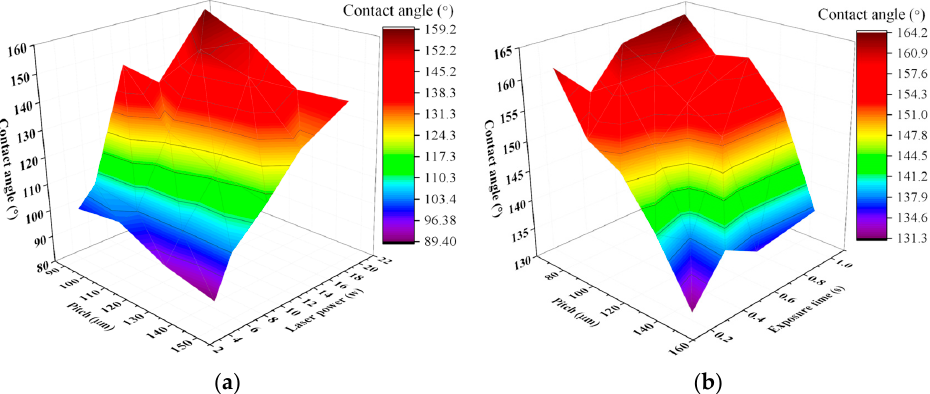
Figure 10. ( a ) 3D colormap of the contact angle as a function of laser power and pitch of microstructures; ( b ) 3D colormap of the contact angle as a function of exposure time and pitch of microstructures.